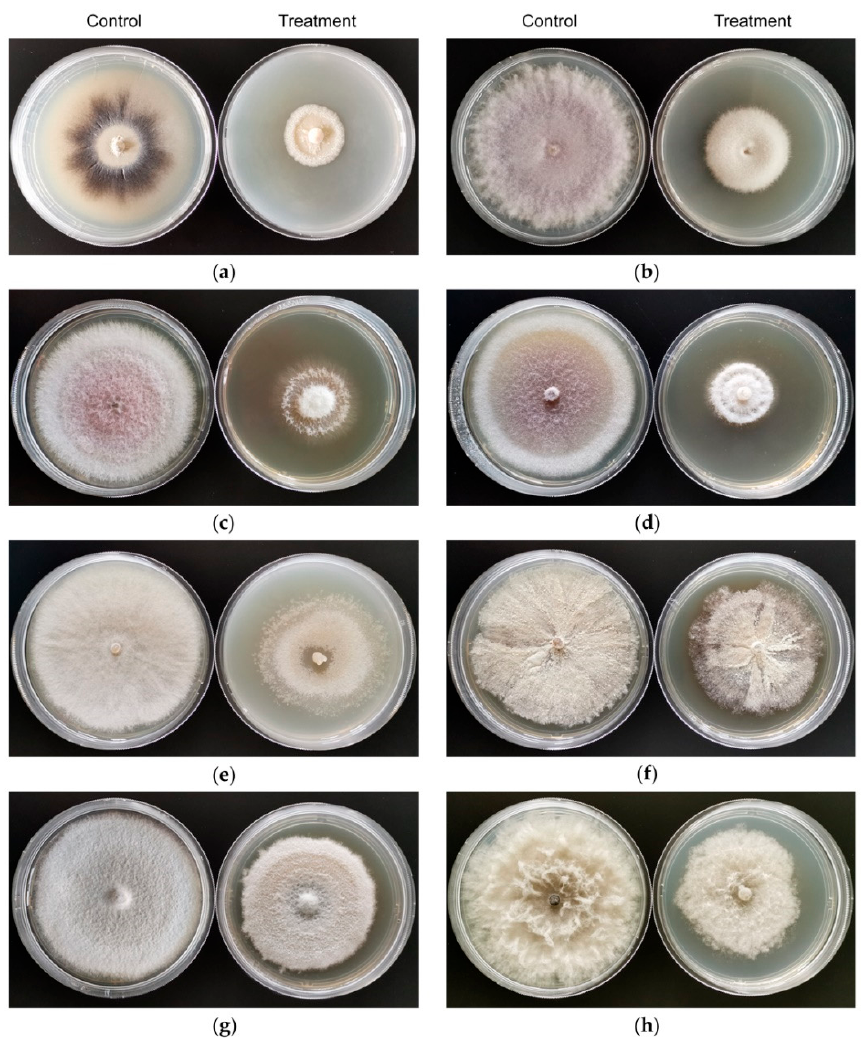
Figure 2. Effect of VOCs emitted by strain CT32 on the growth of 8 phytopathogenic fungi in vitro. In the sealed plates test, fungi in the control groups were cultured on potato dextrose agar (PDA) medium. The mycelial growth of fungi in the treatment groups was suppressed upon exposure to volatiles emitted by strain CT32. ( a ) V. dahliae ; ( b ) F. oxysporum f. sp. fragariae ; ( c ) F. oxysporum f. sp. niveum ; ( d ) F. oxysporum f. sp. cucumerinum ; ( e ) B. cinerea ; ( f ) T. cucumeris ; ( g ) G. cingulata ; ( h ) B. dothidea .